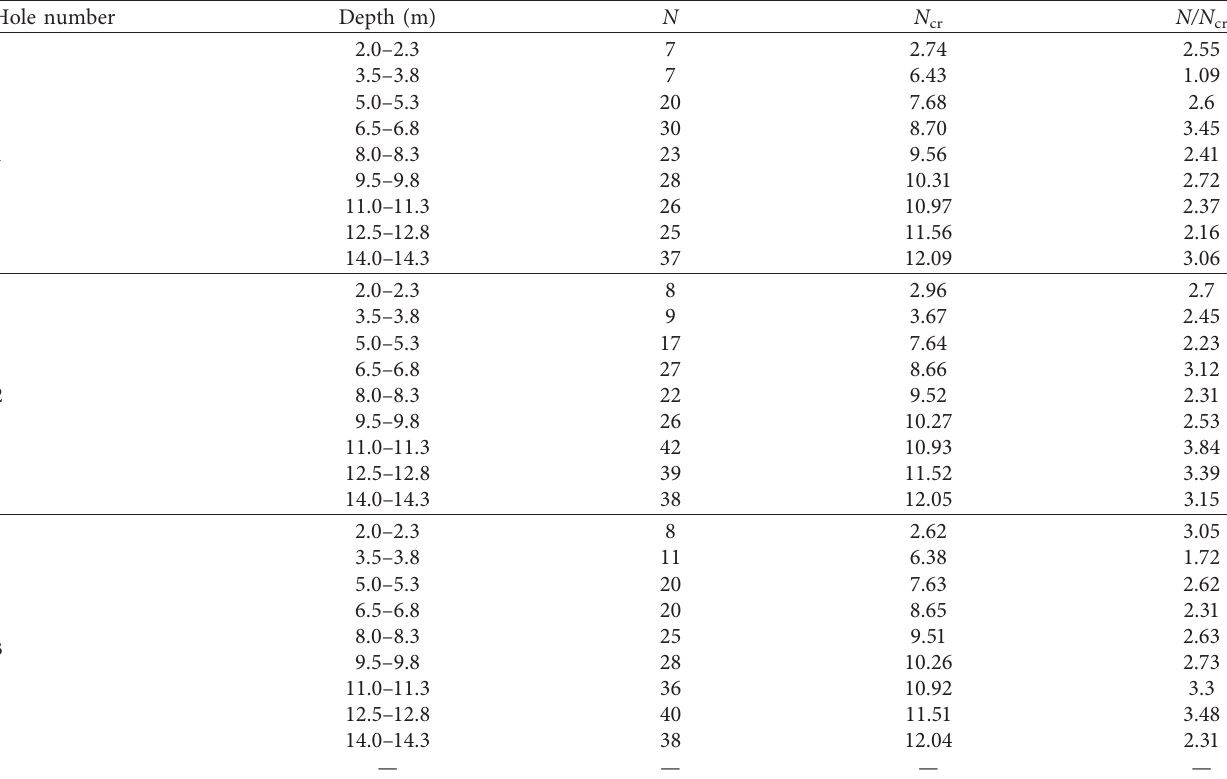
Figure 9: Soil liquefiable discrimination results before foundation treatment. (a) #8 CPT test result. (b) #12 CPT test result. Table 9: Liquefiable evaluations by the